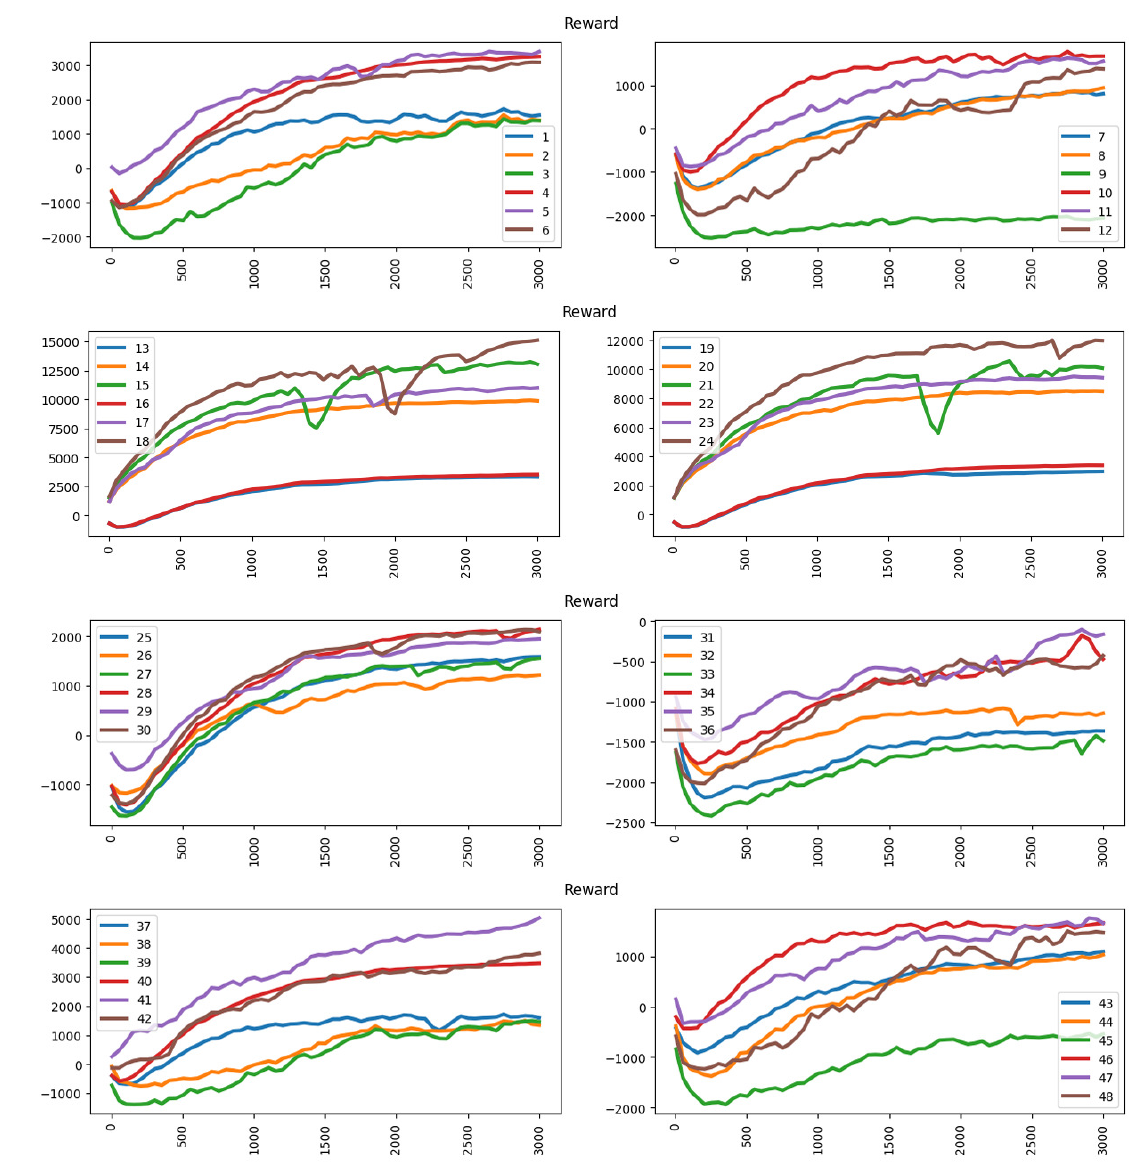
Figure 12. Reward result under the revenue